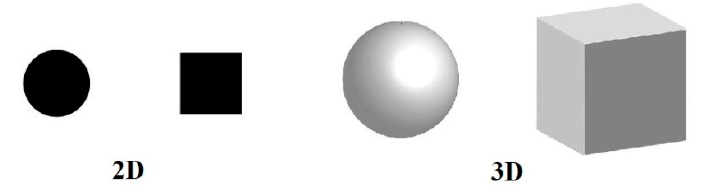
Figure 7. Illustration of SE.